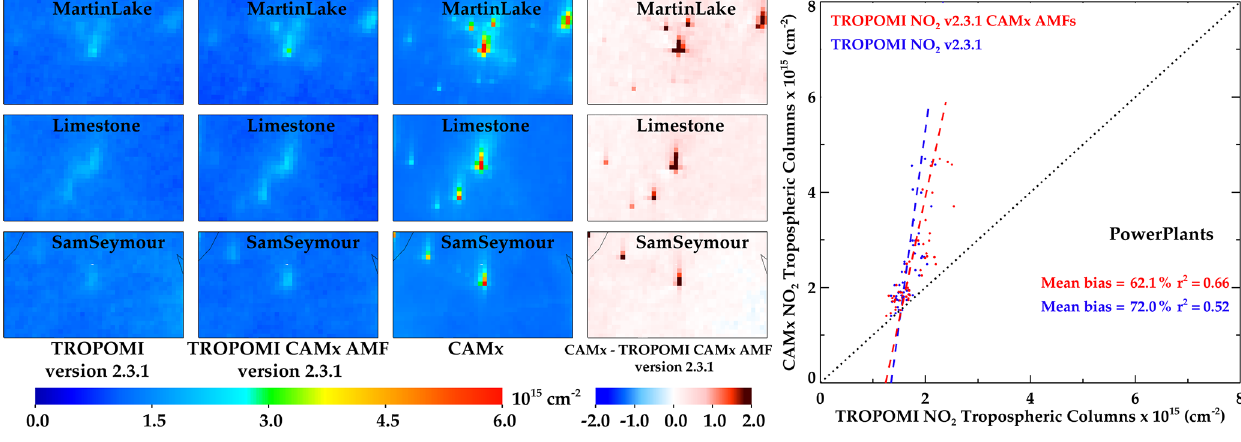
Figure 7. The NO 2 tropospheric vertical column amounts averaged across April through September 2019 from TROPOMI v2.3.1, TROPOMI v2.3.1 with new AMF, and CAMx for the largest three power plants in eastern Texas, i.e., Martin Lake (lat 32.25 ◦ N, long 94.58 ◦ W), Limestone (lat 31.42 ◦ N, long 96.25 ◦ W), and Sam Seymour (lat 29.92 ◦ N, long 96.75 ◦ W). The right panel is a scatterplot showing the slope and correlation of various TROPOMI configurations and